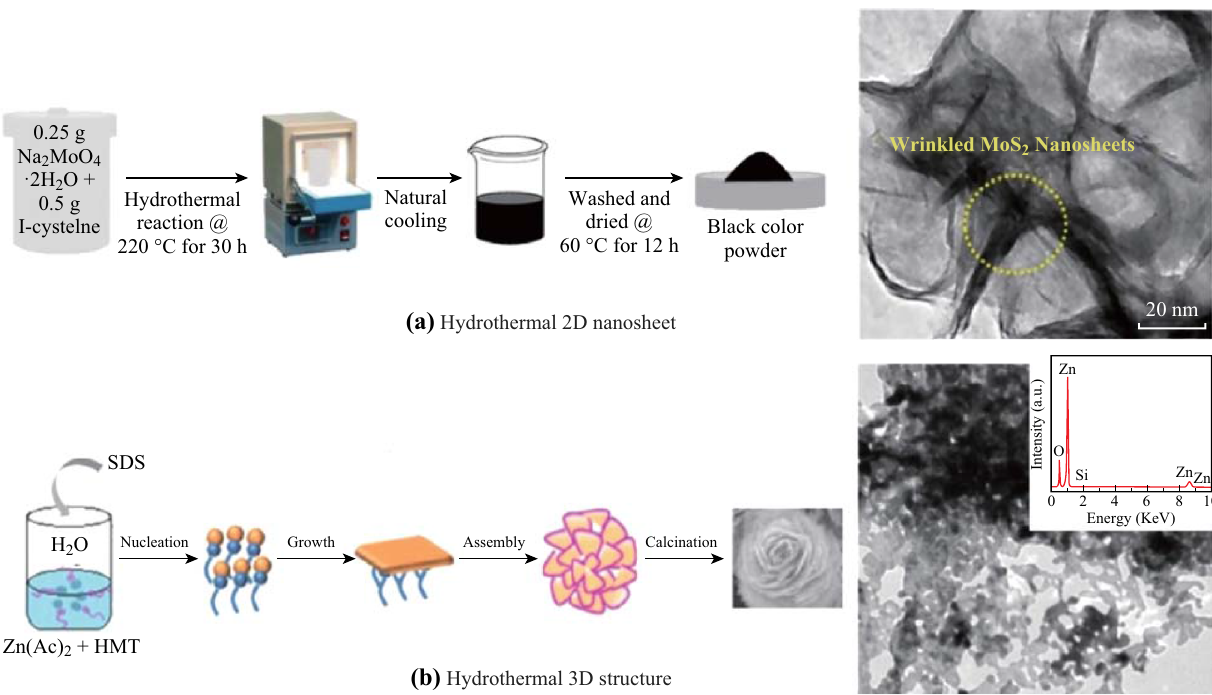
Fig. 5 Schematics of hydrothermal synthesis procedures of a individual 2D nanostructures and b 3D hierarchically assembled structures and their corresponding transmission electron microscopic images. Reproduced with permission from Ref. [84,